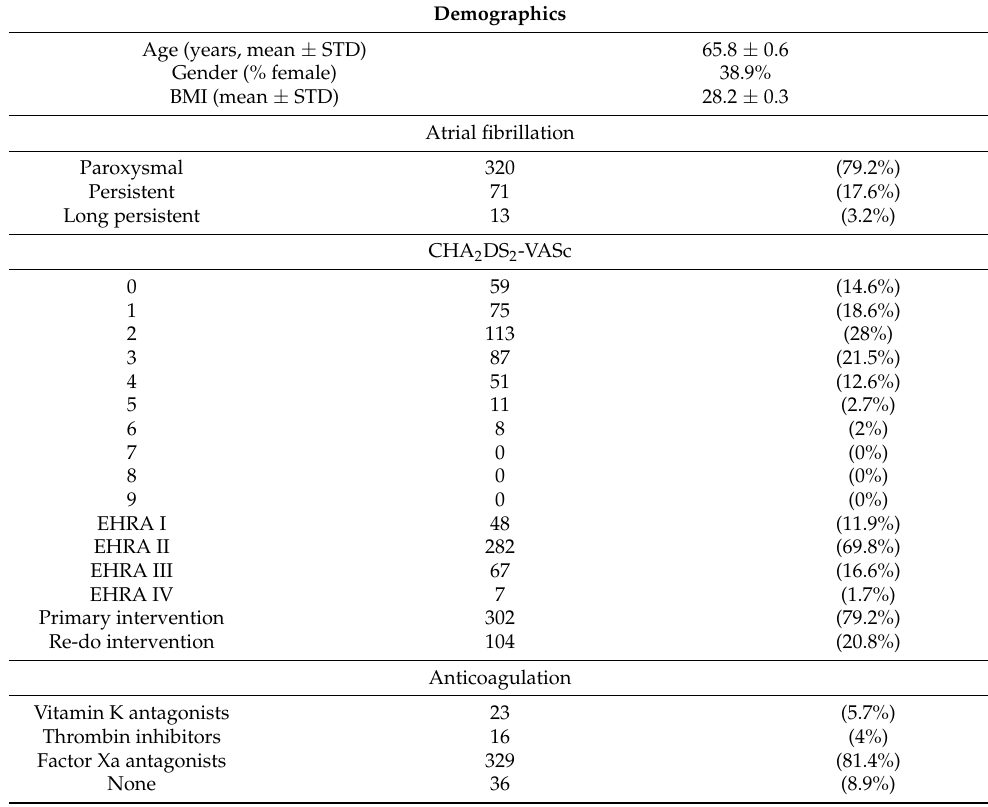
Table 1. Characteristics of 404 patients undergoing transseptal access for pulmonary vein